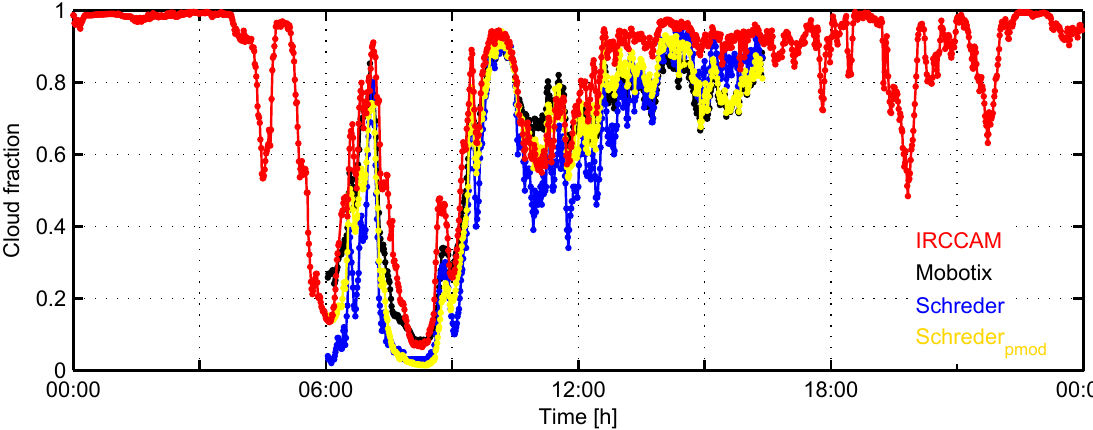
Figure 6. Cloud fraction determined by the analysed cameras and algorithms (red is IRCCAM, black is Mobotix, blue is Schreder, yellow is Schreder pmod ) on 4 April